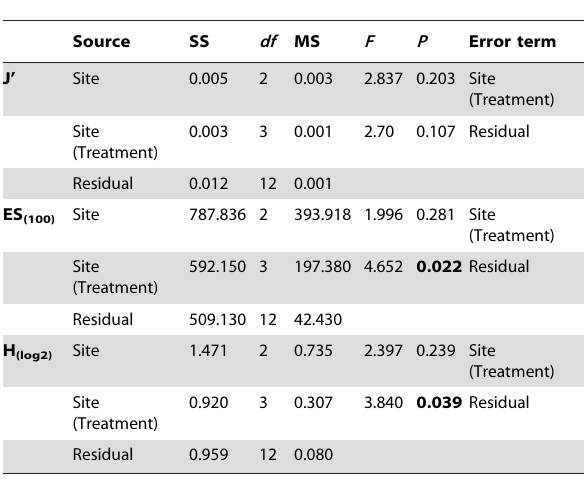
Table 2. Results of the diversity indices for the nematode communities in the sponge (HG2, HG4, HG6) and control cores (HG3, HG5, HG7) (0–1 cm sediment depth).